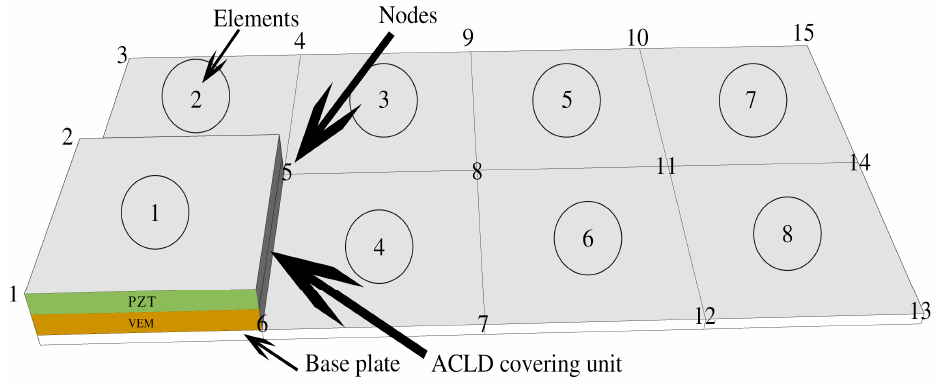
Figure 6. Finite element model of ALCD thin plate structure.